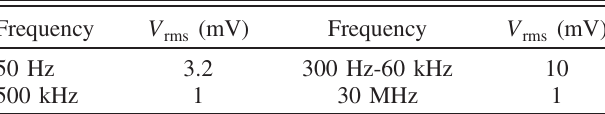
TABLE V. The power supply specifications as a function of the frequency [44,46].